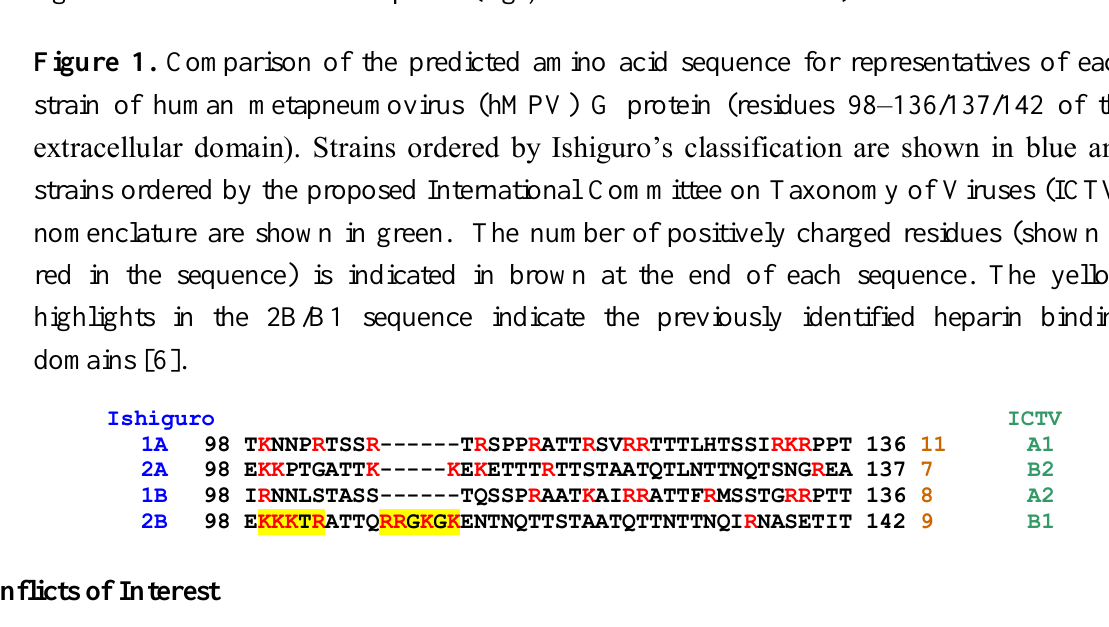
Figure 1. Comparison of the predicted amino acid sequence for representatives of each strain of human metapneumovirus (hMPV) G protein (residues 98–136/137/142 of the extracellular domain). Strains ordered by Ishiguro’s classification are shown in blue and strains ordered by the proposed International Committee on Taxonomy of Viruses (ICTV) nomenclature are shown in green. The number of positively charged residues (shown in red in the sequence) is indicated in brown at the end of each sequence. The yellow highlights in the 2B/B1 sequence indicate the previously identified heparin binding domains